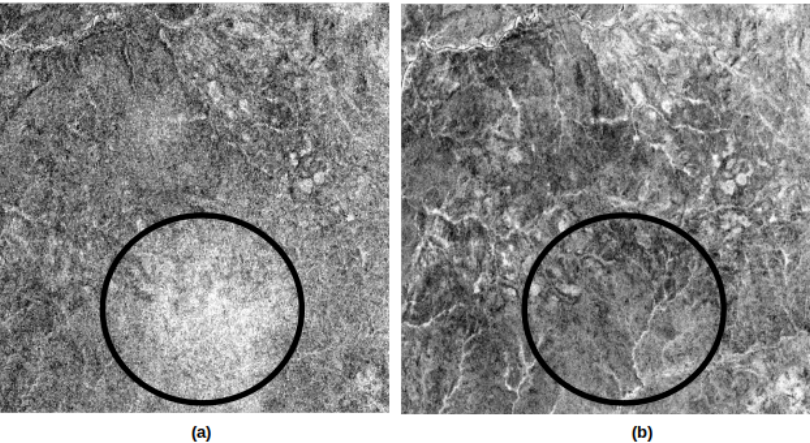
Figure 13. Comparison between two BNP VH-band images: ( a ) image on a single date; ( b ) image with minimumm values of pixels in the time